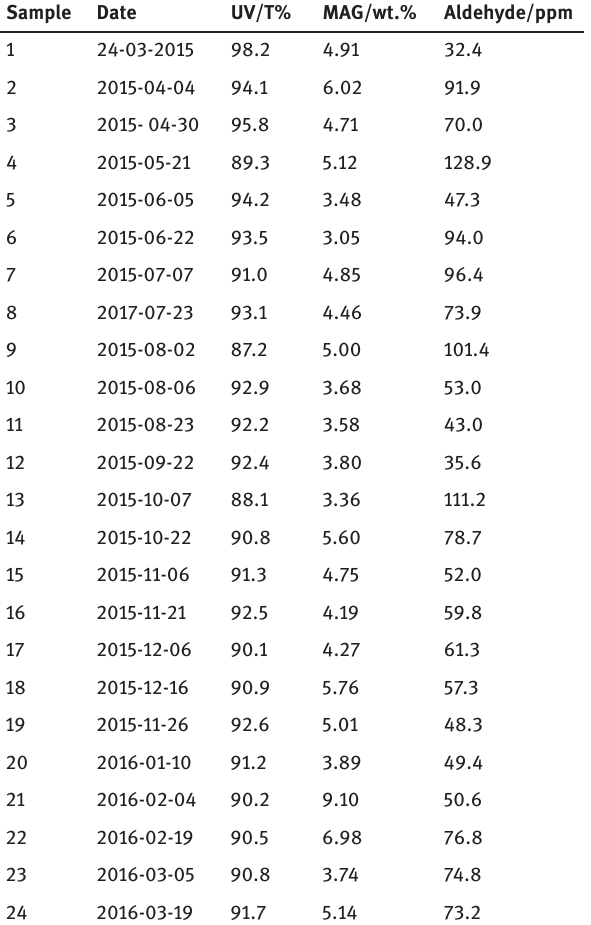
Table 1: Input aldehyde and ethylene glycol and the amount of UV light to enter the